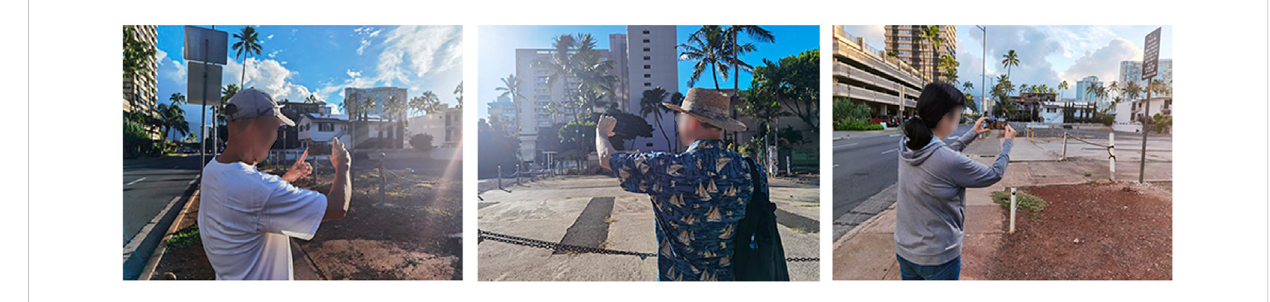
FIGURE 3 Experiencing the AR platform with smartphones on